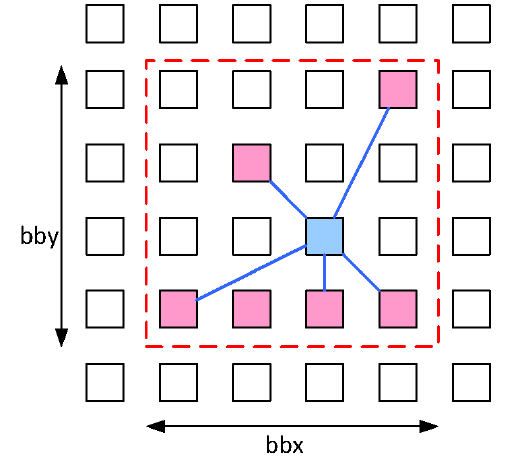
Figure 6. Placement using simulated annealing approach.